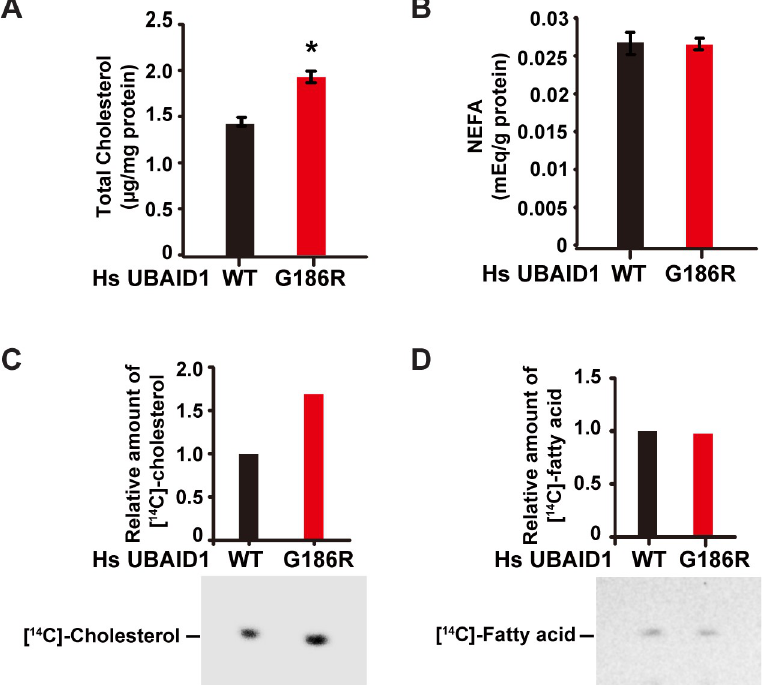
Fig 2. UBIAD1 (G186R) elevates cholesterol biosynthesis. (A-B) Effects of WT UBIAD1 and UBIAD1 (G186R) on the cellular levels of cholesterol (A) and non-esterified fatty acids (B). HEK-293 cells stably expressing human WT and UBIAD1 (G186R) were depleted of sterols and fatty acids in 10% delipidated-FCS, 1 μ M lovastatin and 50 μ M mevalonate for 16 hr. After depletion, cells were washed with PBS to remove lovastatin, and change to medium with 10% delipidated-FCS for 5 hr. Then the lipids were extracted and total cholesterol (A) and non-esterified fatty acids (NEFA) (B) were measured. The protein levels were quantified by BCA method, and used to normalize the lipid content. The data are shown as mean ± SD, n = 3. The p value was calculated with Student’s t test; � , p < 0.05. (C-D) Effects of WT and UBIAD1 (G186R) on de novo synthesis of cholesterol (C) and fatty acid (D). HEK-293 cells stably expressing with WT and G186R UBIAD1, were depleted of sterols and fatty acids in 10% delipidated-FCS, 1 μ M lovastatin and 50 μ M mevalonate for 16 hr. After depletion, cells were washed to remove lovastatin, and change to medium with 10% delipidated-FCS for 3 hr. Then [ 14 C]-acetate (36 μ Ci/100-mm dish) were added and cells were treated for additional 2 hr. Cholesterol (C) and fatty acid (D) were extracted and resolved by thin-layer chromatography. Radioactive signals were visualized with phosphoimager. Signal intensities were quantified by Image- Pro Plus 6 software, and the signals in WT UBIAD1 expressing cells were defined as 1. All experiments are repeated three times and representative data are